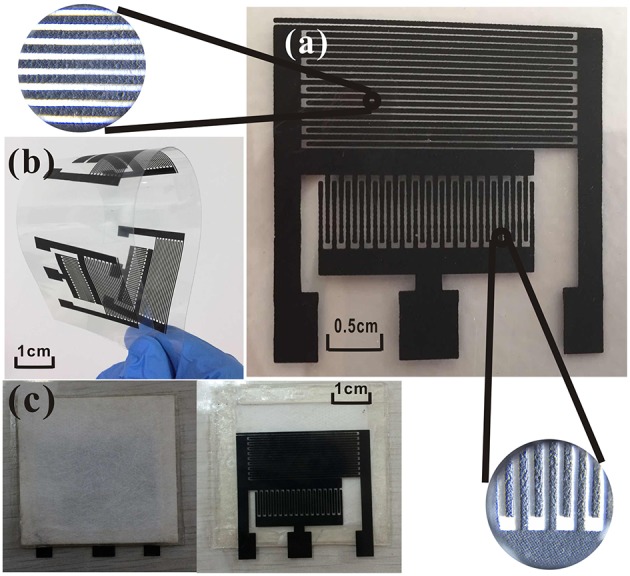
(a) Interdigitated electrode; (b) curved electrode; (c) NO2 sensor.